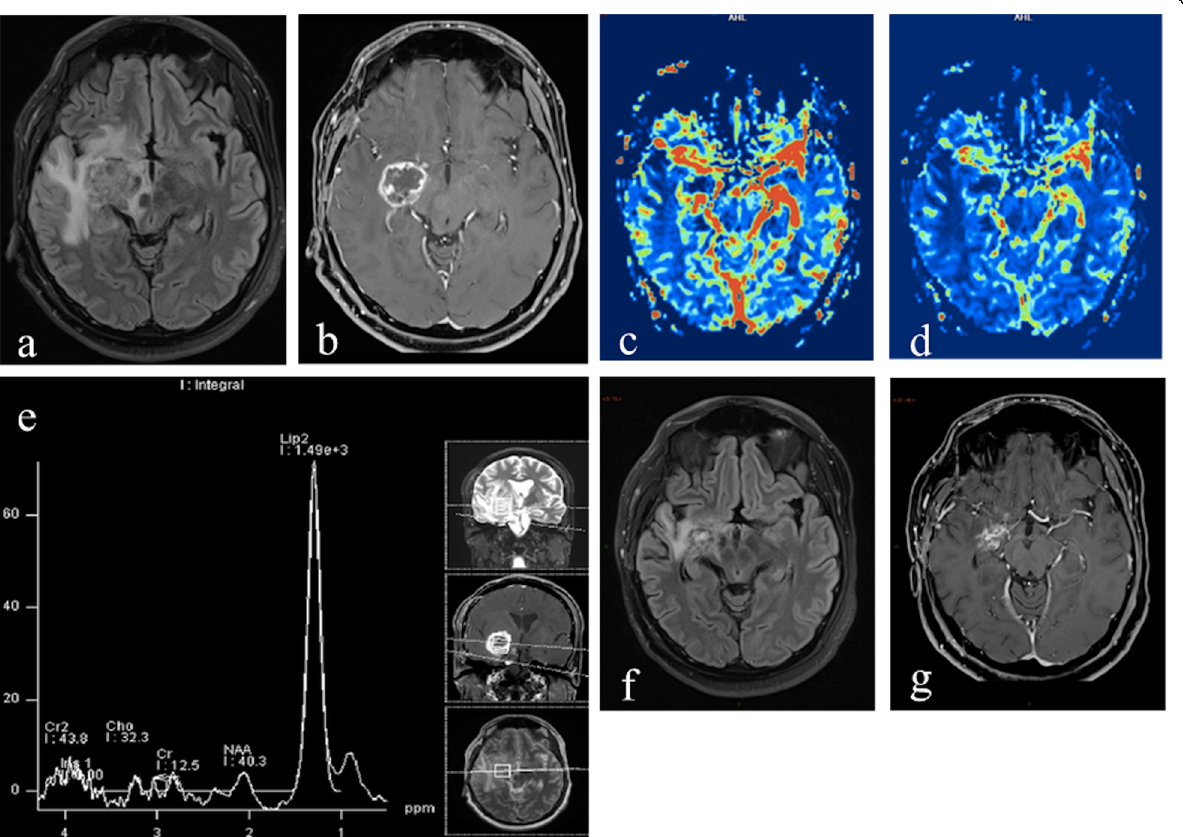
Fig. 4 MRI performed 13 months after proton therapy for clival chondrosarcoma. Axial fluid-attenuated inversion recovery (FLAIR) image ( a ) shows a disomogeneous area of altered signal, with hypo- and hyperintense components, located in the right hippocampal region and surrounded by extensive edema involving subcortical temporal and frontoinsular white matter, the cortico-spinal tract and causing mass effect on the right cerebral peduncle. Axial postcontrast T1-weighted image ( b ) shows peripheral and disomogenous enhancement, with “ soap bubble ” like pattern. rCBV ( c ) and CBF ( d ) maps show no hyperperfusion in the enhancing area. MRS-short TE ( e ) reveals the presence of high lipid and lactate peak with general decrease of other metabolites, highly suggestive for radiation necrosis. Control MRI performed in the same patient after 3 months; no intercurrent therapies. Axial FLAIR image ( f ) shows an evident decrease of the vasogenic edema, confined to temporal lobe. Axial T1-post contrast-weighted image ( g ) shows reduction in size of the enhancing